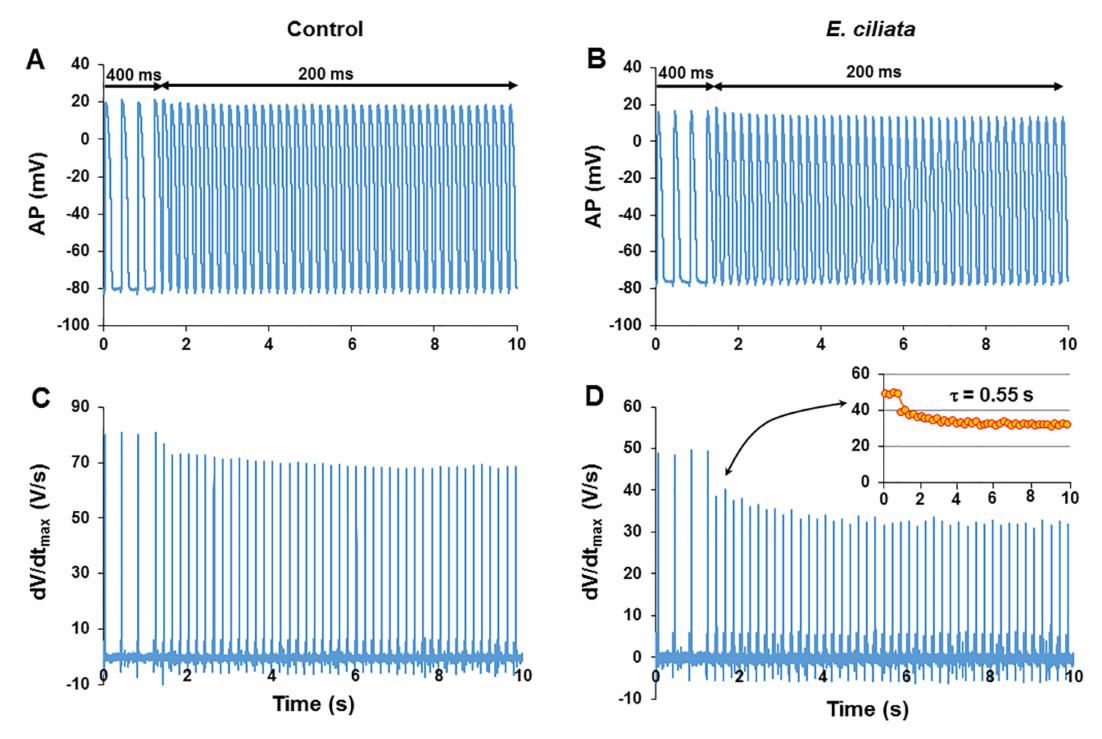
Figure 4. Monitoring the use-dependence e ff ect of the E. ciliata . ( A , B ) APs and ( C , D ) dV / dt max response to abrupt change of the pacing cycle length from 400 ms to 200 ms in the control and after action of the E. ciliata (0.1 µ L / mL), respectively. Arrows on the horizontal bar indicate the moment of the pacing cycle length switch. Notice a stronger reduction of dV / dt max at an increased stimulation rate after application of the E. ciliata vs. control. For detection of the kinetics of dV / dt max depression see Methods, ( D , Insert ) experimental points of dV / dt max fitted with exponential decay (line) with τ = 0.55 s. In the control, an increase in the pacing rate slightly reduced both the AP amplitude and duration, and slowed the dV / dt max down by 10.7 ± 2.1% with time constant ( τ ) of 2.37 ± 0.09 s ( n = 7) (Figure